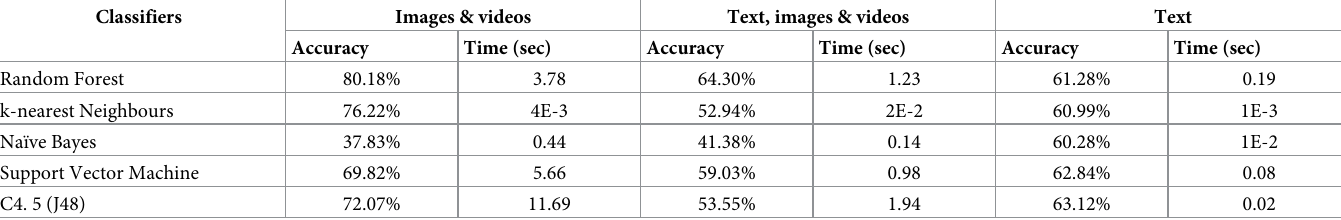
Table 3. Model accuracy from different functions in